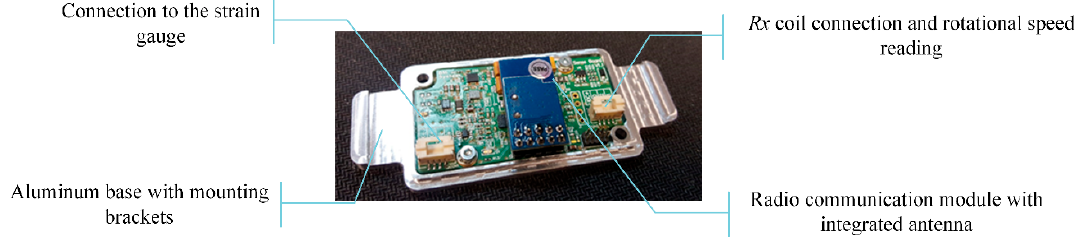
Figure 5. Construction of the non-stationary part with its main components.